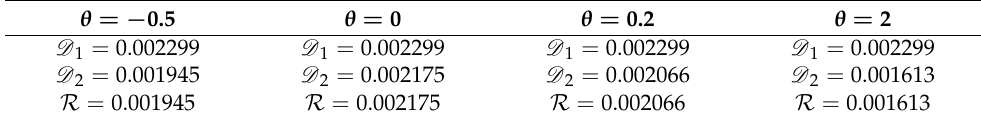
Table 3. Radii of convergence balls for Example